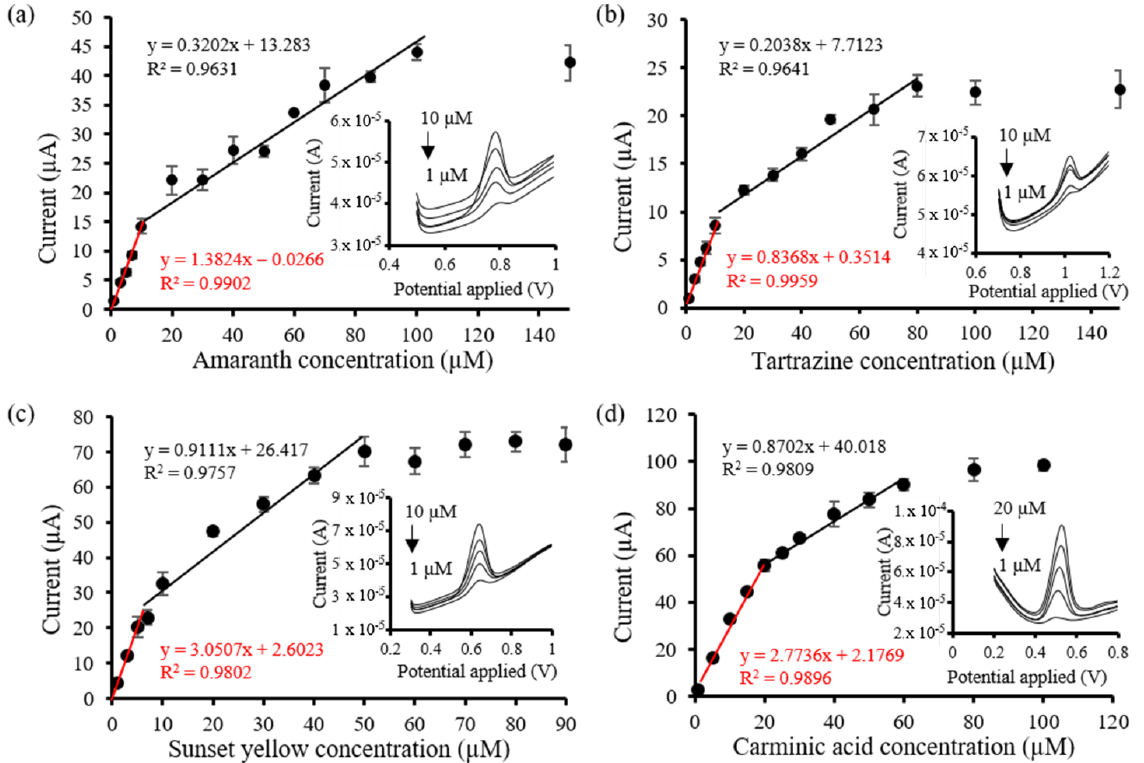
Figure 7. The linear relationship between the oxidative current response and concentration of amaranth ( a ), tartrazine ( b ), sunset yellow ( c ), and carminic acid ( d ). The insets represent the differential pulse voltammograms at the first linear detection range of each dye .